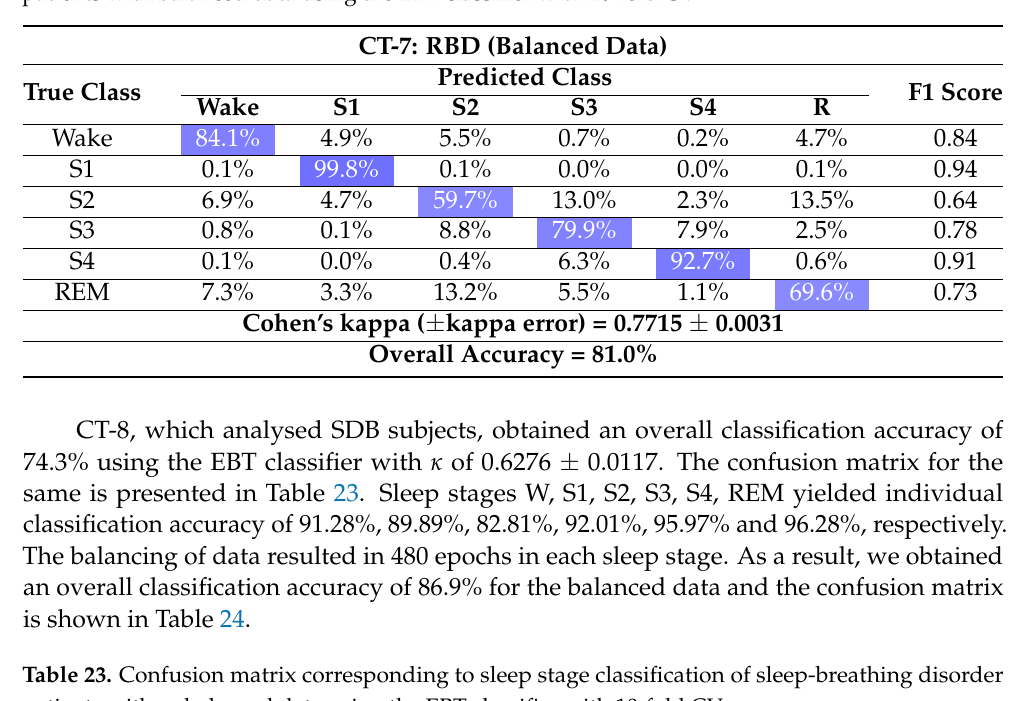
Table 22. Confusion Matrix corresponding to sleep stage classification of REM behavioural disorder patients with balanced data using the EBT classifier with 10-fold CV.